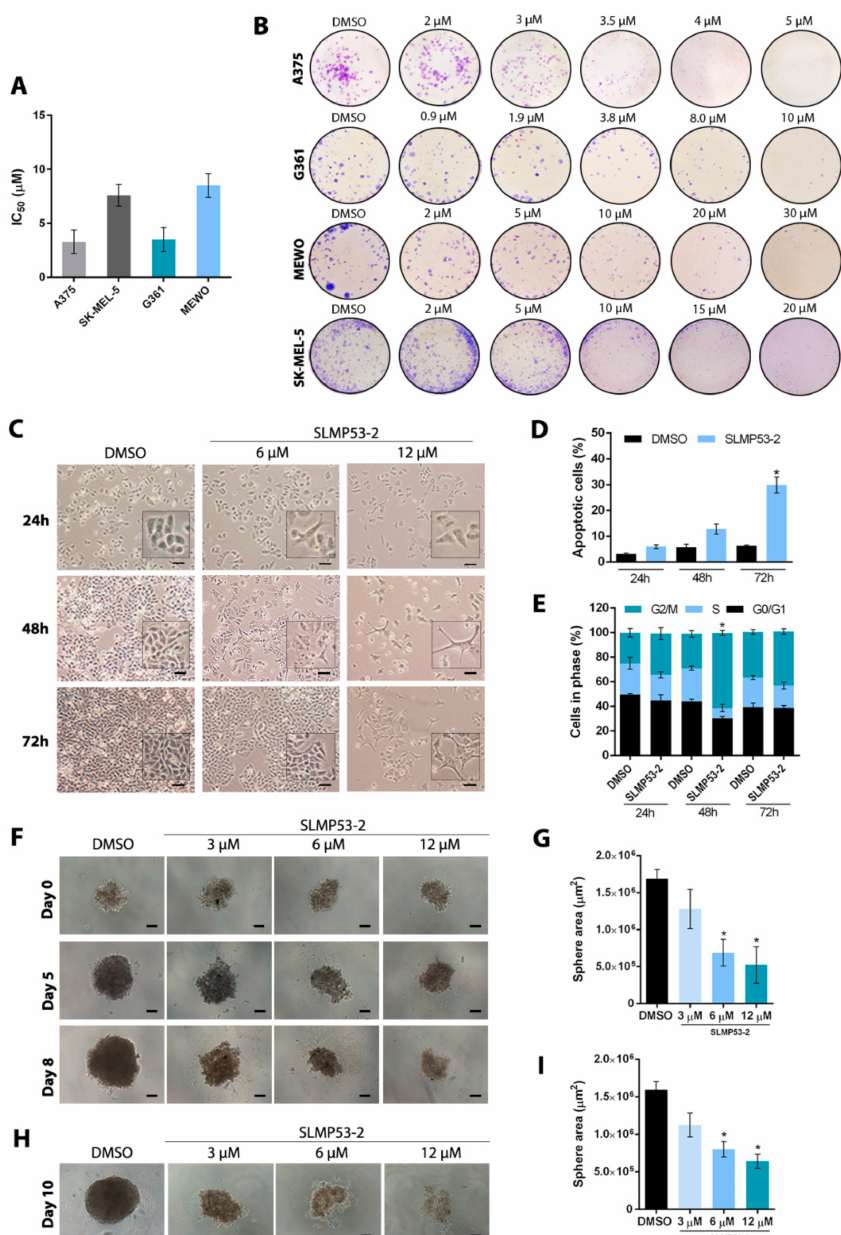
Figure 1. SLMP53-2 inhibits melanoma cell growth through induction of cell cycle arrest and apoptosis. ( A ) IC 50 values of SLMP53-2 in A375, G361, MEWO and SK-MEL-5 melanoma cells obtained by colony formation assay for 11 days; data were normalized to DMSO and correspond to mean ± SEM, n = 5 (two replicates each). ( B ) Colony formation assay for A375, G361, MEWO and SK-MEL-5 melanoma cells treated with SLMP53-2 for the indicated concentrations. Images are representative of five independent experiments. ( C ) Effect of SLMP53-2 on growth and morphology of A375 cells for the indicated time points; images are representative of five independent experiments (scale bar = 100 µ m, magnification= × 100). ( D ) Apoptosis (Annexin V-positive cells) was evaluated in A375 cells after 24, 48 and 72h of treatment with 12 µ M SLMP53-2. ( E ) Cell cycle analysis in A375 cells was determined after 24, 48 and 72 h of treatment with 12 µ M SLMP53-2. In ( D , E ), data are mean ± SEM, n = 5; values are significantly different from DMSO: * p < 0.05, one-way ANOVA followed by Tukey’s test. ( F , G ) Effect of SLMP53-2 on three-day-old A375 spheroids, for up to 8 days of treatment. In G , data are mean ± SEM, n = 5; values are significantly different from DMSO: * p < 0.05, one-way ANOVA followed by Tukey’s test. ( H , I ) Evaluation of spheroid formation after 10 days of treatment with SLMP53-2; treatment was performed at the seeding time of A375 cells. In I , data are mean ± SEM, n = 5; values are significantly different from DMSO: * p < 0.05, one-way ANOVA followed by Tukey’s test. In ( F , H ), images are representative of five independent experiments; scale bar = 100 µ m; magnification = 100 ×